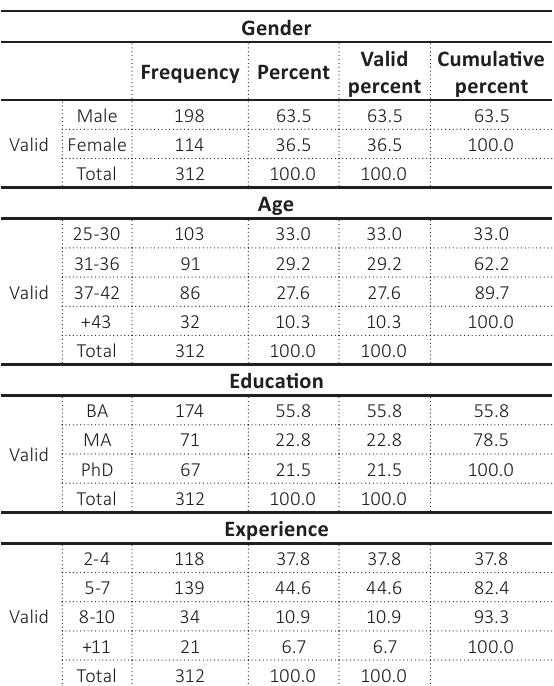
Table 2. Sample distribution according to